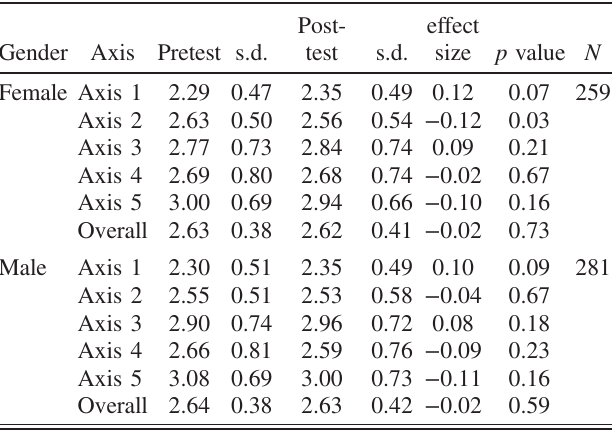
TABLE IX. EBAPS modified spring pretest and post-test results by gender.